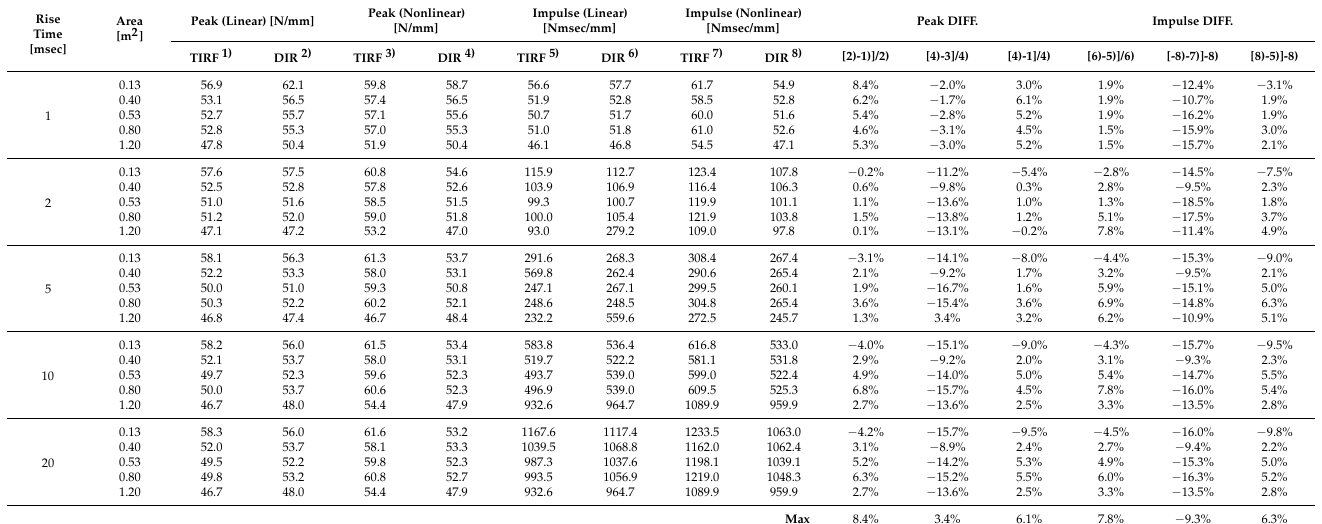
Table 9. Shear responses for LNG cargo containment boxes with hull structure (Model 3).